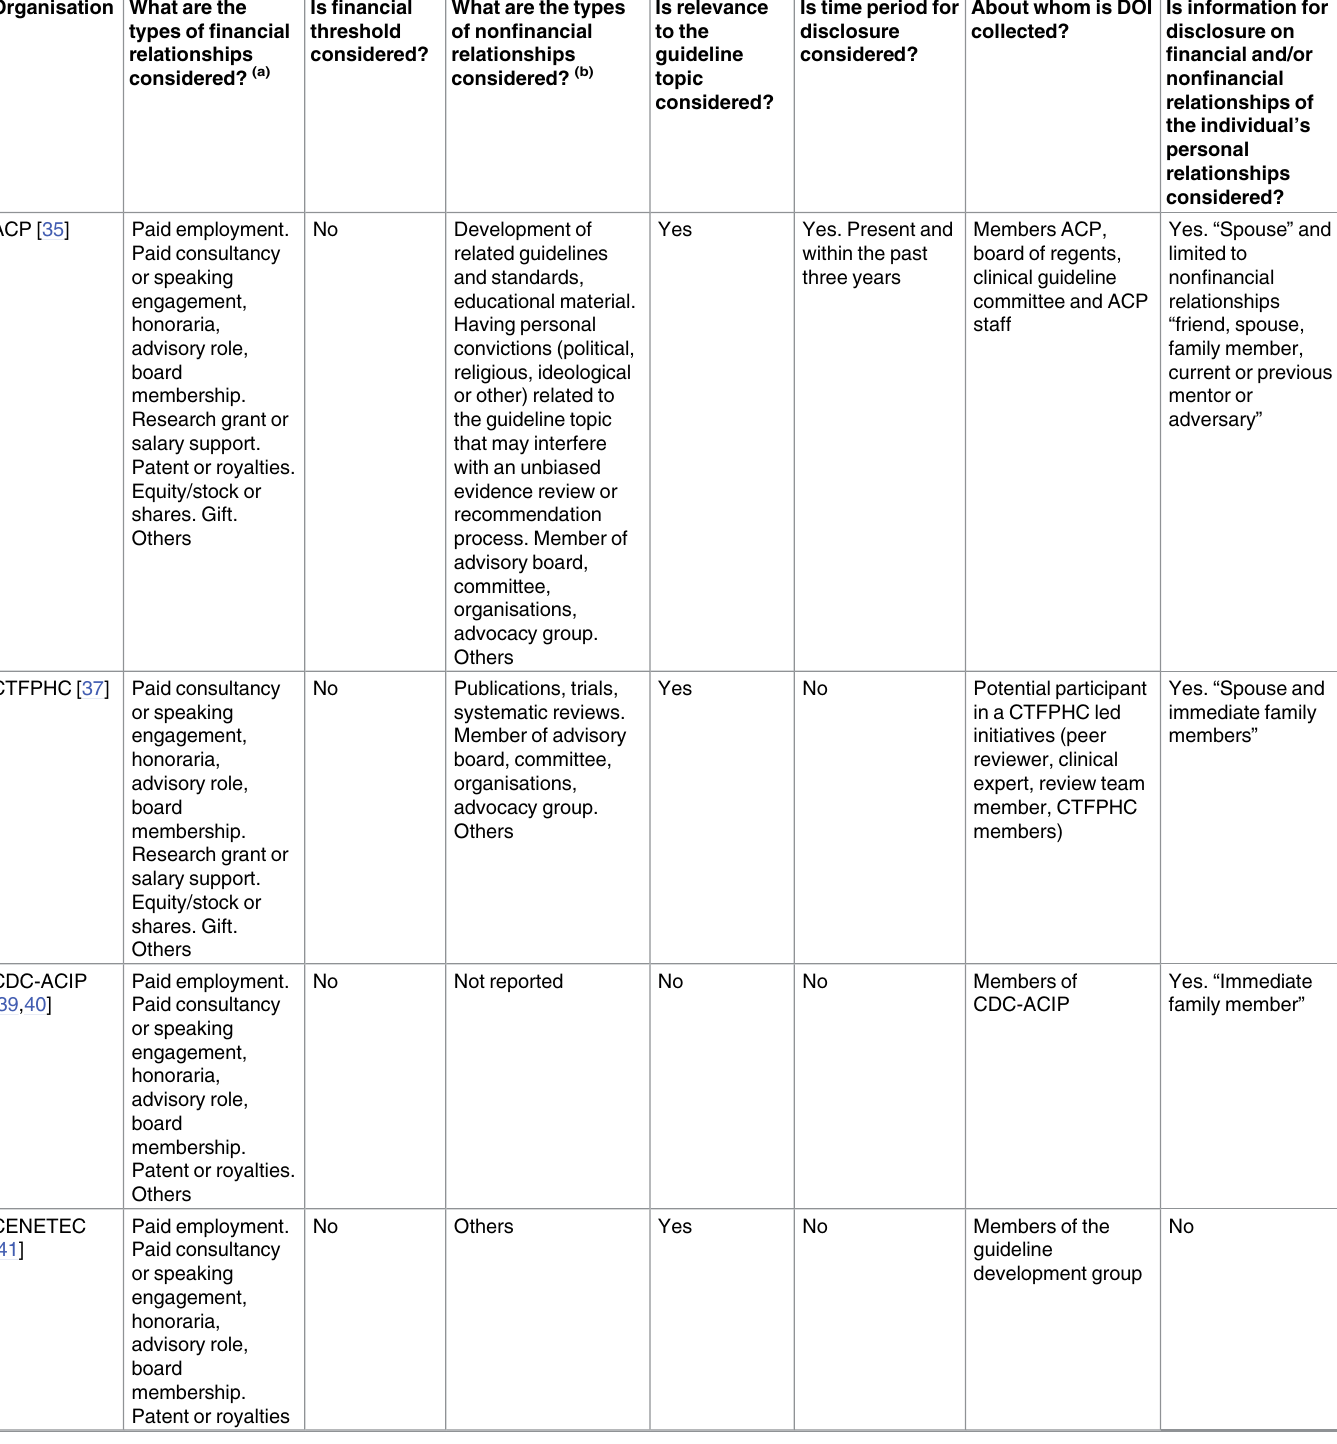
Table 4. Disclosure of relationships of